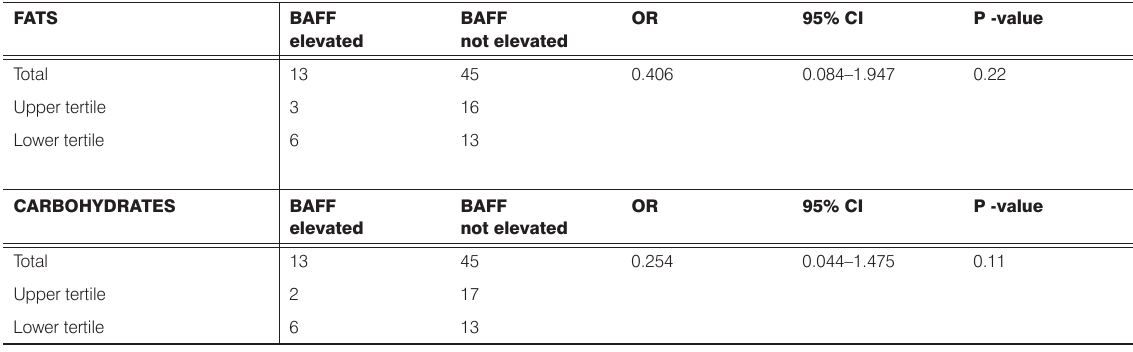
Table 3. Association between the upper and lower tertiles of fat and carbohydrate intake for elevated or normal BAFF plasma levels in the study cohorts FATS BAFF BAFF OR 95% CI P -value elevated not elevated